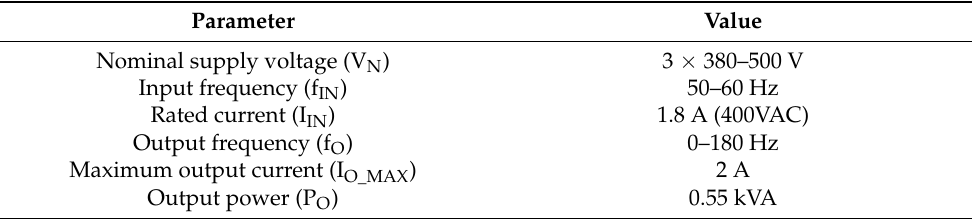
Table 3. Parameters of the tested frequency converter (MDX61B0005-5A3-4-00).